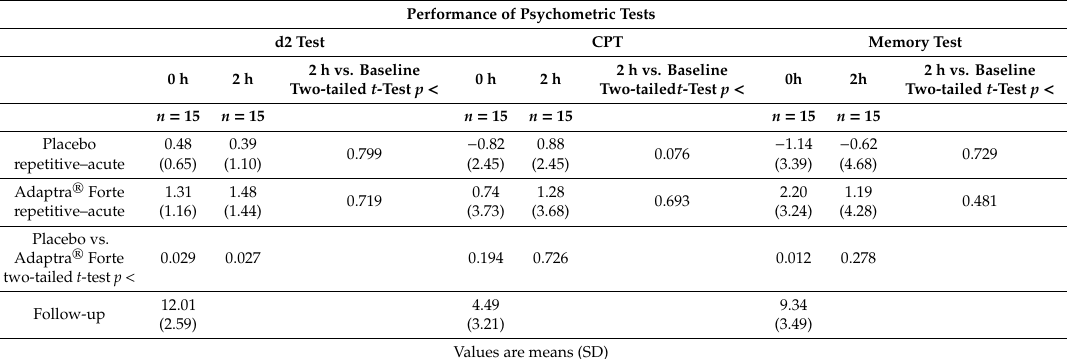
Figure 6. Result of discriminant analysis. Acute effect during eyes open recording condition: Adaptra Forte ac; repetitive effect during eyes open recording condition: Adaptra Forte re. Results from first 3 discriminant functions are displayed with respect to space (x, y, and z coordinates. Results from the next 3 discriminant functions are displayed as additive color mixture similarly to RGB mode on a TV. If preparations are projected in rather close proximity, they cannot well be discriminated from each other, which means they have a similar effect or can be used within a similar clinical indication. Table 4. Change compared with the baseline in the psychometric scores (d2-Test, ME-Test, and CPT), profile of mood state rate (POMS), and the quality of sleep scores at the end of four weeks of treatment with Adaptra ® Forte compared with the placebo. Note that n = 14 for the d2-attention-Test at 0 h for Adaptra ®